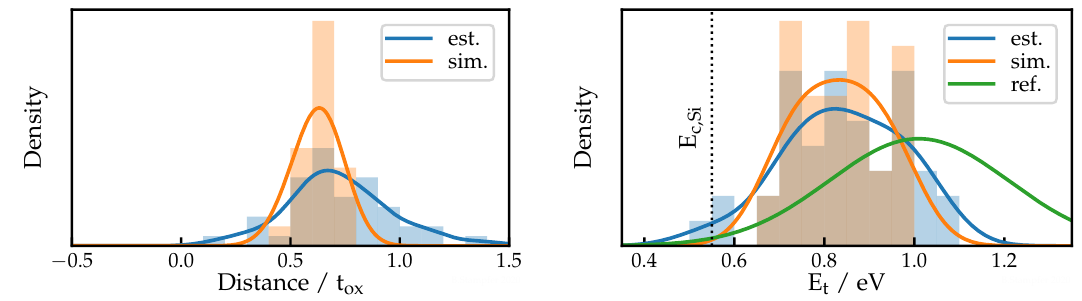
Figure 9. Distributions of positions and trap levels from technology computer aided design (TCAD) simulations compared to the estimations made for the same defects. Energies are referenced from Si-midgap, with E f,i taken from the simulation. The electron defect band at E t = 1.01eV from [30] is shown for comparison. The defects we observe are distributed mainly in the lower half of this